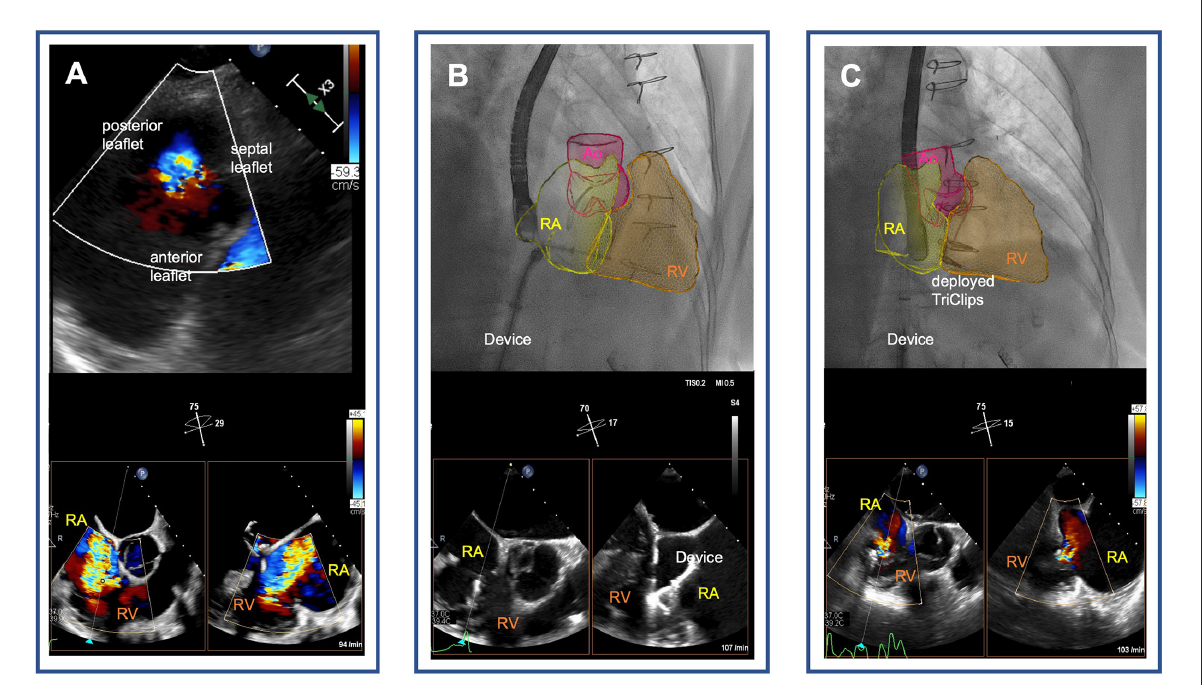
FIGURE1 Tricuspid transcatheter edge-to-edge repair following surgical tricuspid annuloplasty. (A) Severe functional tricuspid regurgitation following sutured annuloplasty [transgastric view on the tricuspid valve (upper panel) and biplane transesophageal echocardiographic images of the right ventricular outflow tract (lower panel) ]. (B) Real-time fusion imaging-assisted navigation of the transcatheter tricuspid valve repair device through the right atrium pointing to the tricuspid annulus (upper panel) . Biplane transesophageal echocardiographic images of the right ventricular outflow tract showing grasping of the septal and anterior leaflets of the tricuspid valve with the TriClip device (lower panel) . (C) Mild tricuspid regurgitation after deployment of two TriClips [real-time fusion of echocardiography-derived right heart cavities on fluoroscopy visualizes the TriClips (upper panel) , and biplane esophageal echocardiographic image demonstrates reduction of tricuspid regurgitation to mild degree (lower panel) ]. RA, right atrium; RV, right ventricle; Ao,